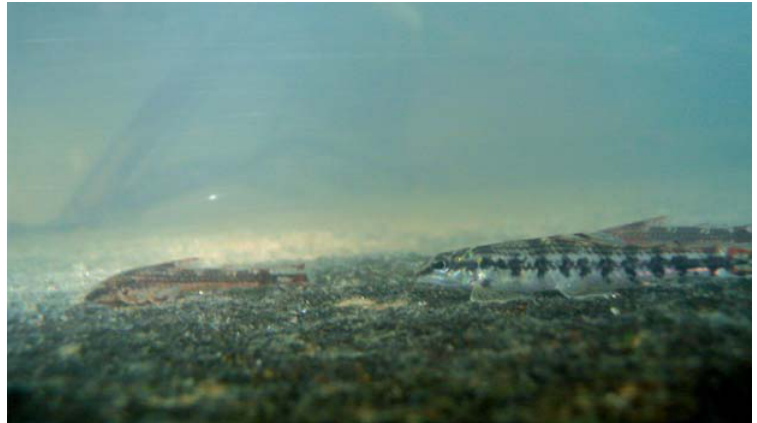
Fig. 1. An individual of Characidium sp. positioned behind a grazing catfish, Parotocinclus maculicauda , on a large submerged rock in a fast flowing stretch of the rio do Ouro stream. Photo by R. Leitão.